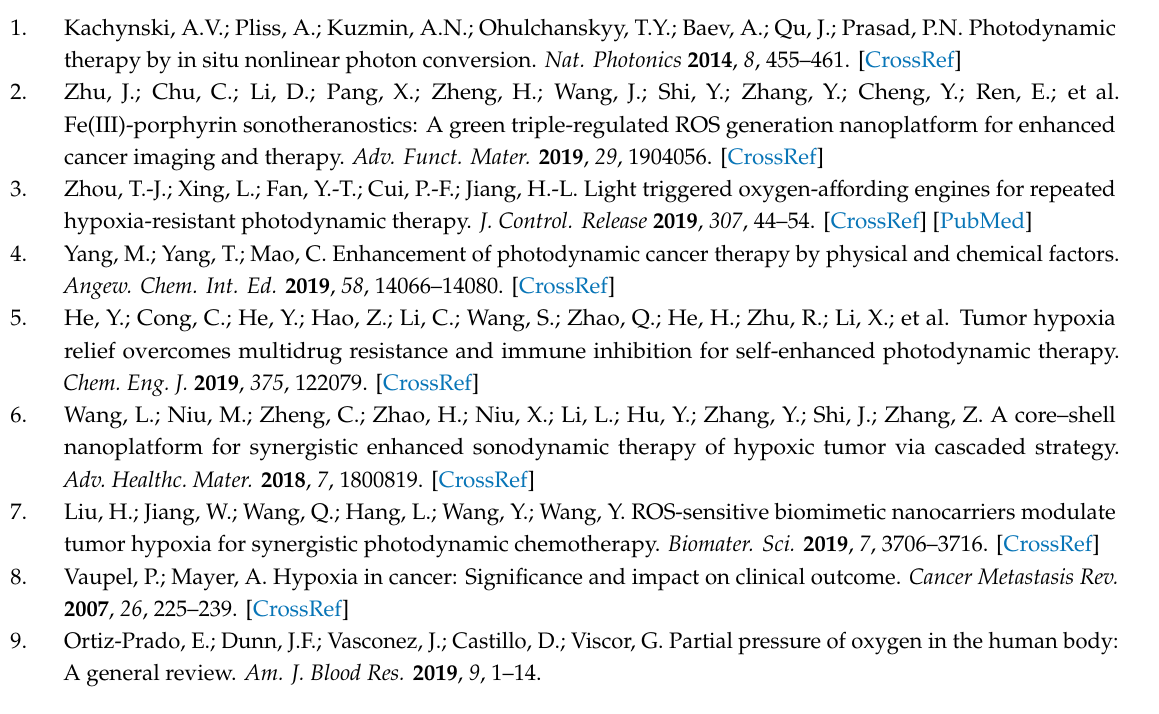
Figure S1: Droplet diameter change of the Ce6-P / W NEs in phosphate bu ff ered saline throughout storage at 37 ◦ C for 24 h, Figure S2: 1 O 2 production of Ce6 Es and Ce6-P / W NEs under ultrasonic irradiation in normoxic condition at ( a ) 1 mg / mL or ( b ) 0.5 mg / mL Ce6-P / W NE, Figure S3: Calcein staining and corresponding bright-field images of PC-3 cells treated with Ce6 Es or Ce6-P / W NEs upon light irradiation for 30 s in normoxic condition, Figure S4: / W NEs at 200 µ g / mL at di ff erent tissue depth when irradiated with white 1 O 2 production of Ce6-P